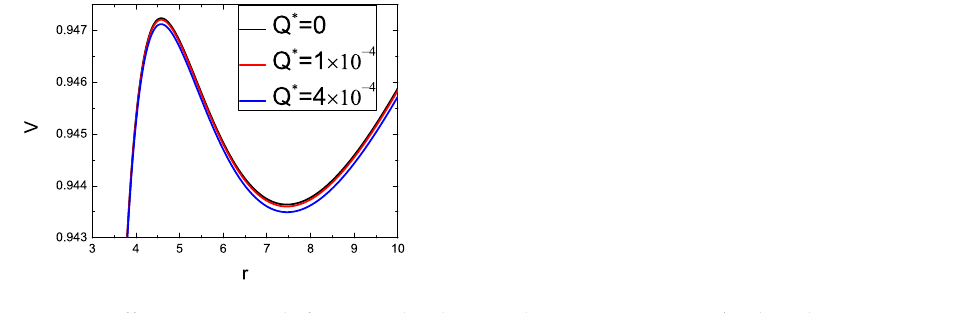
Figure 2. Effective potentials for several inductive charge parameters Q ∗ . The other parameters are √ B ∗ = 0.001, a = 0.1 and L = 2 3.